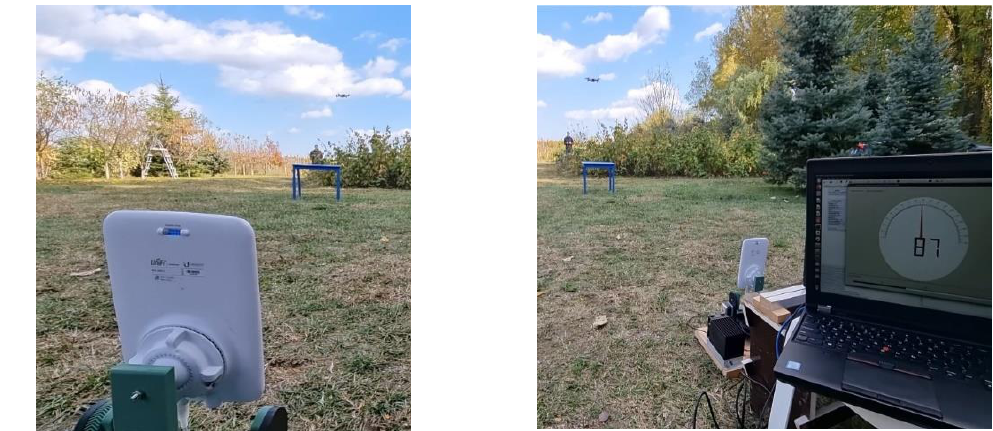
Figure 5. Tests performed using the DronEnd ground system (DJI Mavic AIR target drone). The estimated angle of incidence can be noticed. estimated angle of incidence can be